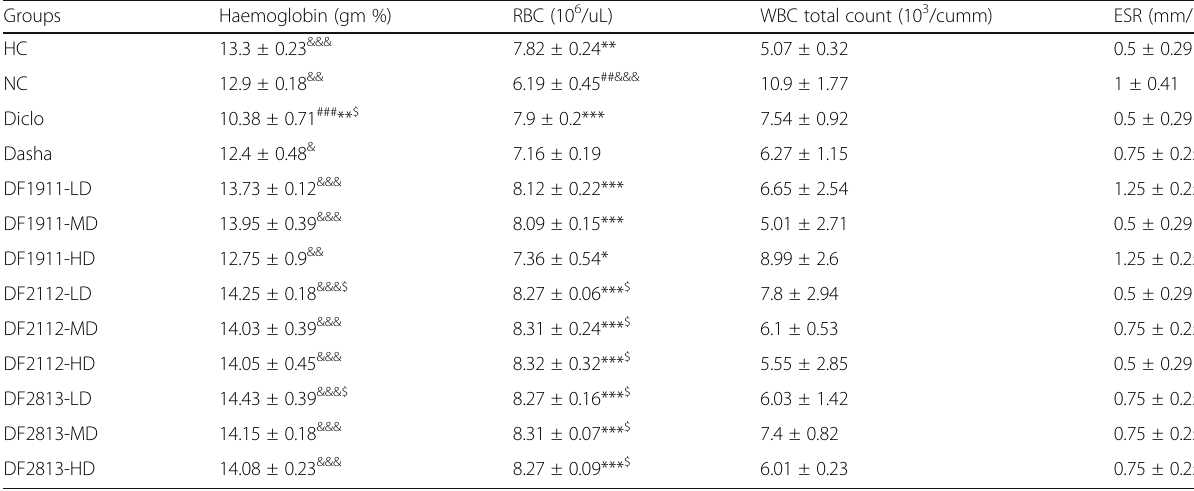
Table 6 Alterations in hematological parameters in CFA-induced inflammation in rats